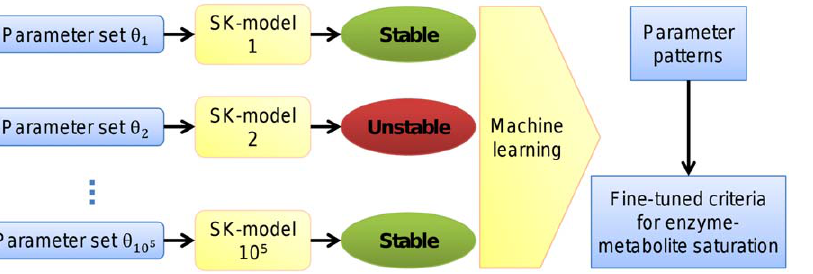
Figure 1. Workflow for Monte Carlo based model generation and the subsequent detection of patterns by decision trees. First, a large number of SK-models is created based on randomly sampled parameter sets. They allow the detection of those parameter sets that lead to a stable or unstable steady state, respectively. Using the model parameters as feature vectors and the stability information as class labels, a classifier can learn those patterns in the parameter space with highest discriminatory power between both classes. These patterns then describe quantitative criteria for the degree of saturation of individual enzymes in the pathway that ensure stability or instability.